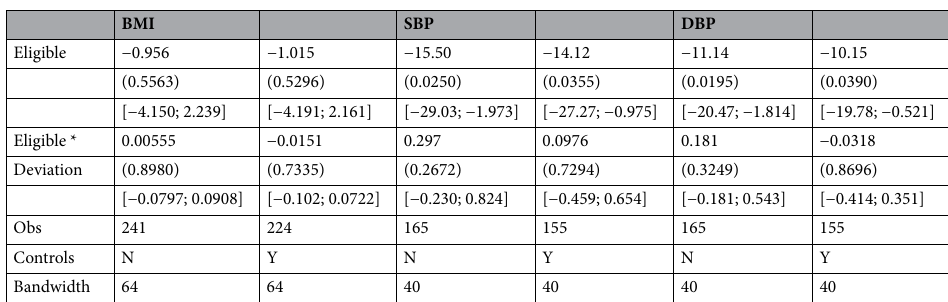
Table 2. Estimates for linear specifications with and without controls. The controls are years of education, age, age squared, sex, and years since the CD4 test. Eligible* deviation refers to the interaction of the eligibility indicator and the deviation variable. The bandwidths are determined by a data-driven routine introduced in Calonico et al. 33 . P-values are reported in parentheses, 95% confidence intervals in square